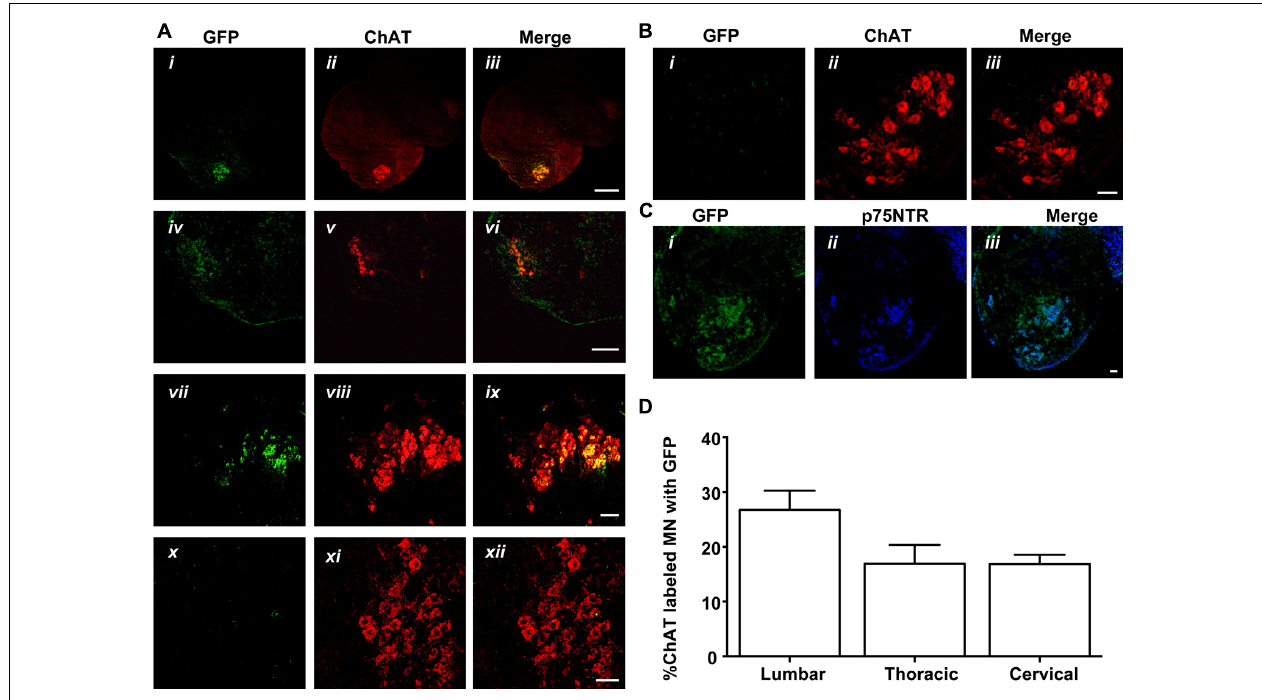
FIGURE 6 | MLR2-PEI-PEG12-pVIVO2 but not PEI-PEG12-pVIVO2 is retrogradely transported to motor neurons in neonatal mice and GFP expressed. (A) Two doses of 75 μ g of MLR2-PEI-PEG12-pVIVO2 carrying 58 μ g pVIVO2 (N/P 12) was injected into neonatal mice and 72 h later spinal cords excised and examined for GFP expression ( n = 5). Motor neurons in the lumbar (ii), thoracic (iv), and cervical (vii) regions were identified by staining with ChAT (1/5000) and GFP expression identified with chicken anti-GFP (1/500). Motor neurons that expressed GFP (i,iv,vii) always contained ChAT (iii scale bar: 100 μ m; vi scale bar: 100 μ m; ix scale bar: 50 μ m). Motor neurons from control sections of untreated mice identified by ChAT (xi), did not contain GFP fluorescence (x) after treatment with chicken